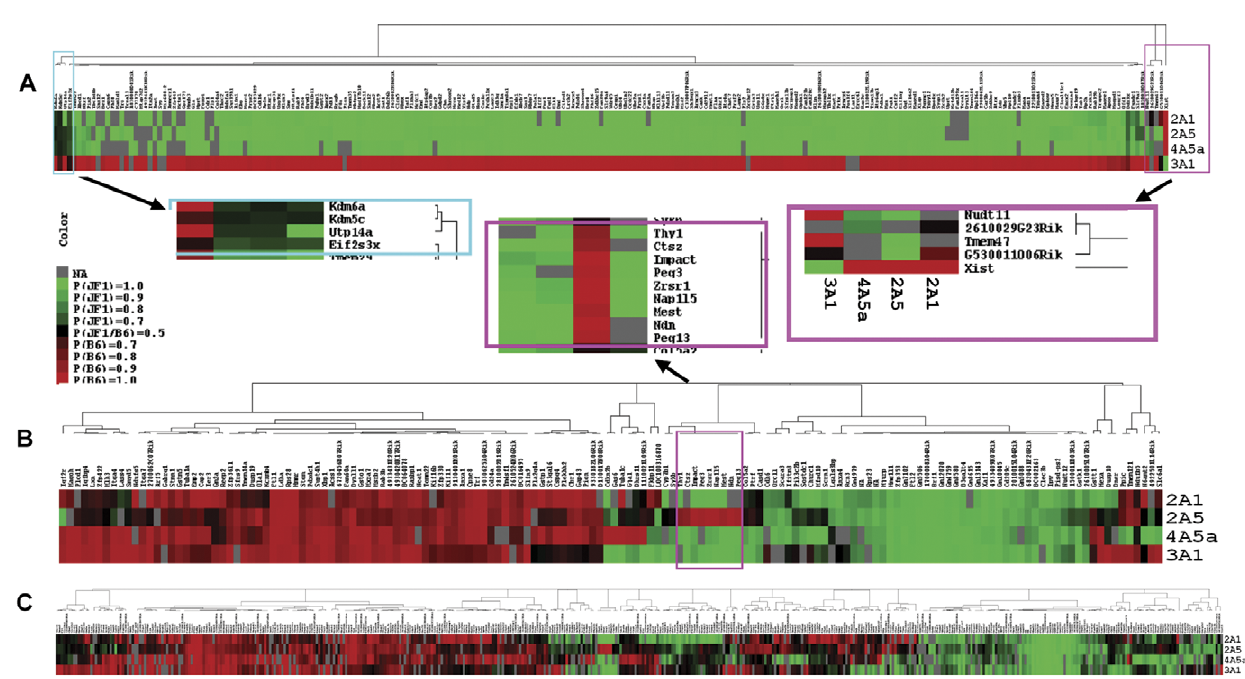
Figure 2. Heatmaps showing results of cSNP analysis. A. X linked genes (n=235) evaluable for at least 2 out of the 4 cell lines. Insets expand results of hierarchical clustering. Right inset : Unique pattern of the Xist gene. Left inset: Genes that escape X-inactivation (see text). B. Autosomal genes (n=152) that show monoallelic expression in at least 2 of 3 evaluable cell lines. Inset: Genes that show imprinted gene expression. C. Autosomal genes (n=476) with monoallelic expression in at least 1 of 2 evaluable cell lines.